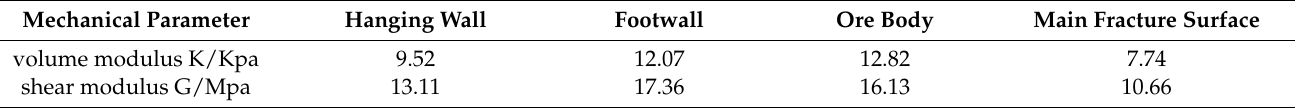
Table 2. Parameter of bulk modulus and shear modulus.